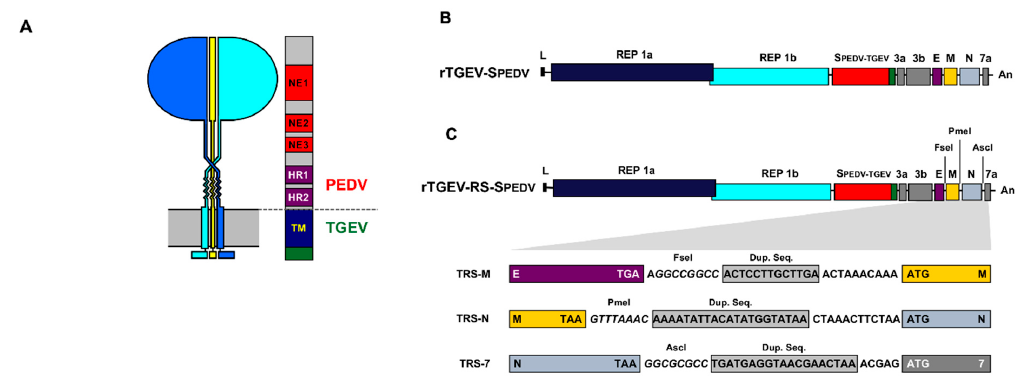
Figure 1. Generation of rTGEV-SPEDV viruses. ( A ) Diagram of the chimeric spike (S) protein expressed by the virus. A representation of spike peplomer is indicated in the left. The scheme on the right indicates the S protein sequence from porcine epidemic diarrhea virus (PEDV) and from TGEV. Relevant S protein domains are indicated: NE, domains recognized by neutralizing antibodies; HR, heptad repeat domain; TM, transmembrane domain. ( B ) Scheme of the recombinant TGEV virus genome encoding a chimeric S protein (SPEDV-TGEV). Labels above the boxes indicate viral genes. L, leader sequence; An, poly A tail. ( C ) Scheme of the rTGEV virus expressing the chimeric S protein from an attenuated background containing transcription regulating sequences (TRSs) duplication and the introduction of restriction sites, as described in [46]. Engineered restriction sites are in italics, duplicated sequences (Dup. Seq.) into grey boxes. Each gene is in a color box as in the upper virus genome scheme, with stop and ATG codons indicated.